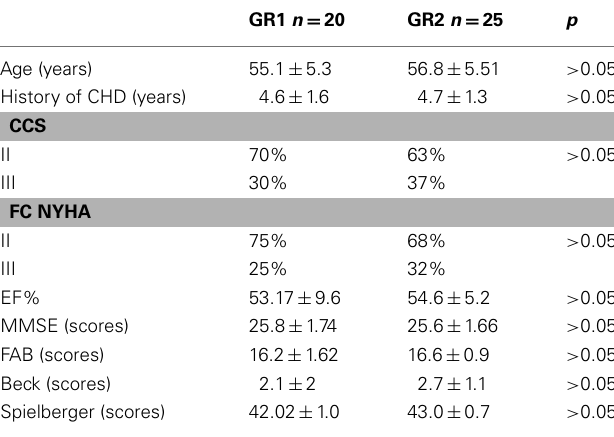
Table 1 | Demographical and clinical characteristics of the